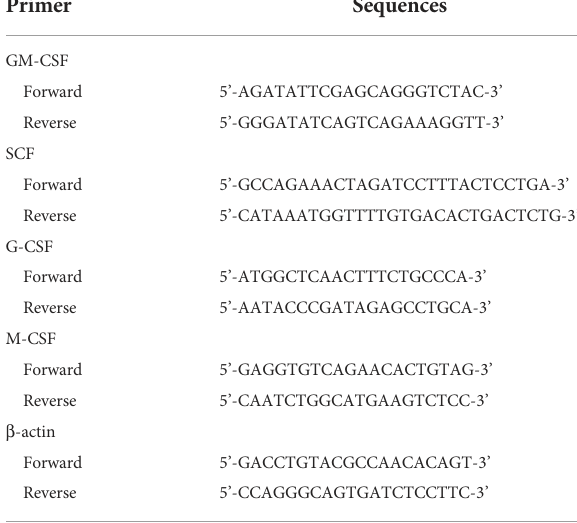
TABLE 1 Primers used in this